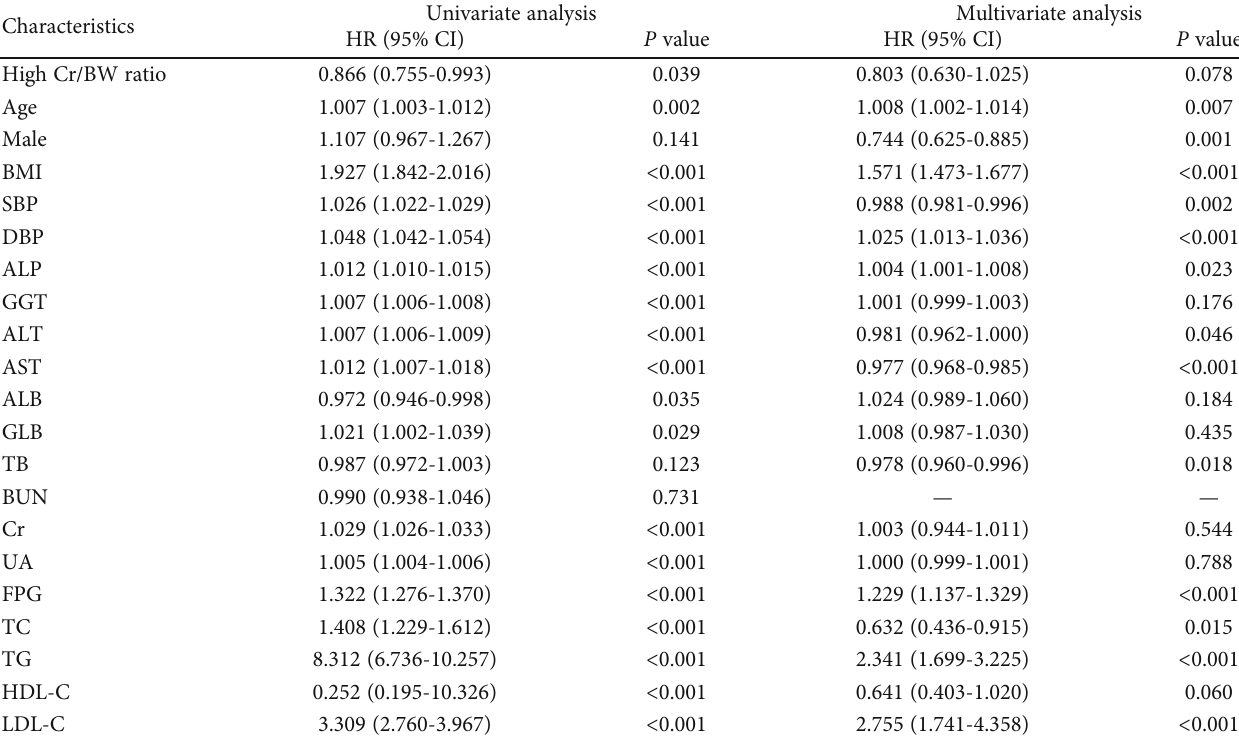
Table 4: Univariate and multivariate Cox regression analysis for incident nonalcoholic fatty liver disease. Characteristics